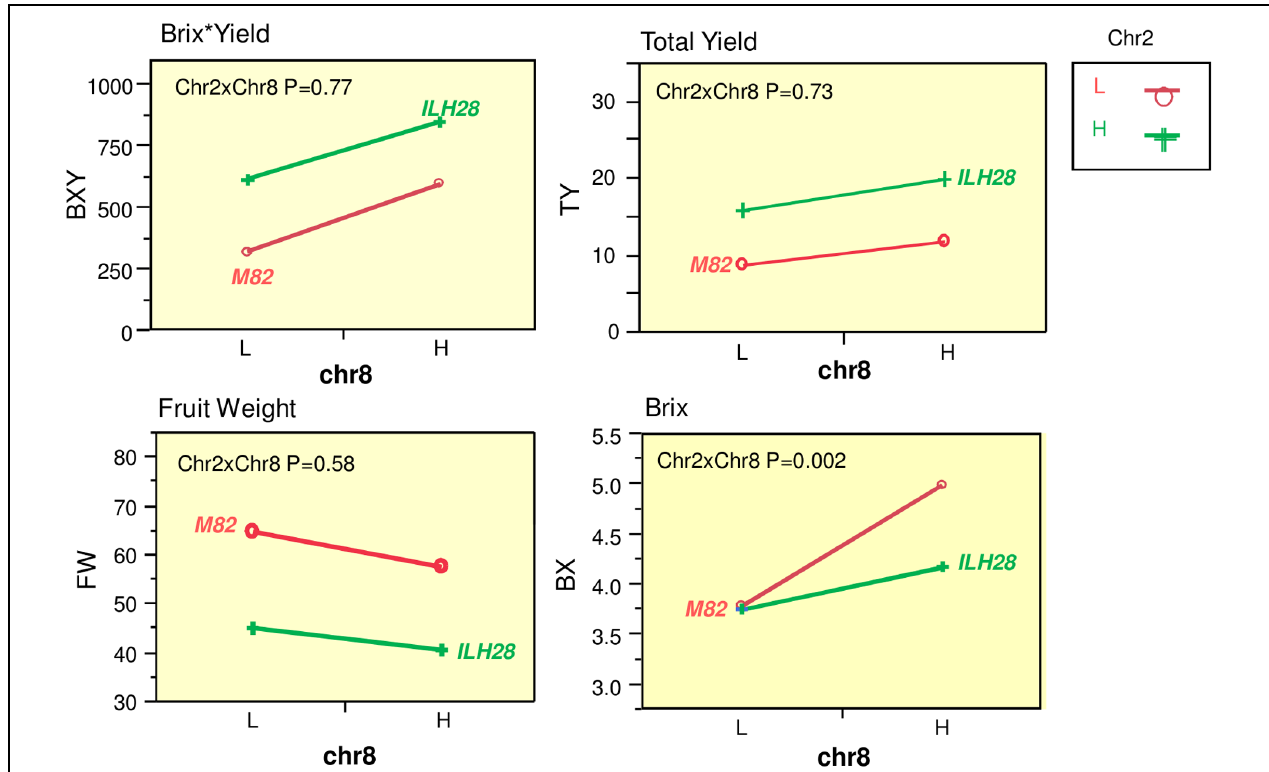
FIGURE 3 | Interaction plots for yield components between the underlying QTLs at the ILH28 double-stack. Two-locus genotypic effects for ILH2-5, ILH8-3, and the double introgression hybrid ILH28. Presented are plots for Brix ∗ Yield (BXY; g sugar/m 2 ), Total Yield (TY; Kg/m 2 ), Fruit Weight (FW; g), Brix (BX; %). X axis (Chr8) are genotypes at IL8-3. The red lines represent genotypes homozygous for the S . lycopersicum allele at IL2-5, the green lines represent genotypes heterozygous at IL2-5. L = homozygote S. lycopersicum allele. H = Heterozygote. Chr2 reffer to IL2-5, Chr8 refer to IL8-3. Chr2xChr8 reflects the interaction as calculated from a two-way